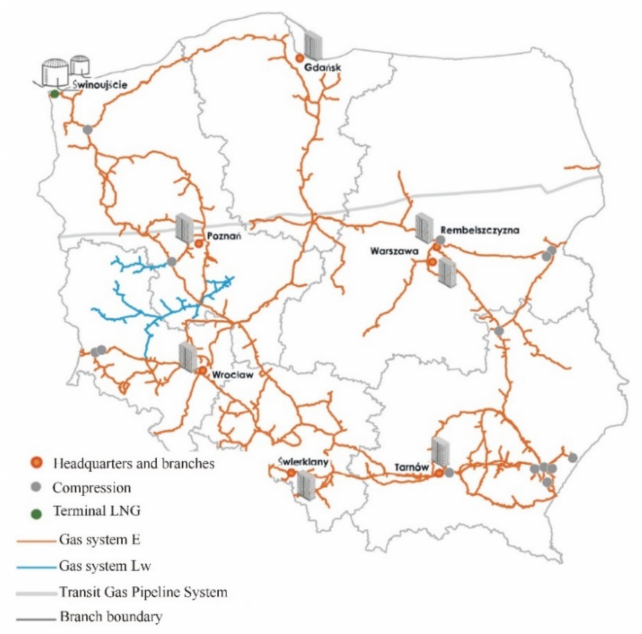
Figure 14. Gas grid in Poland; own elaboration based on